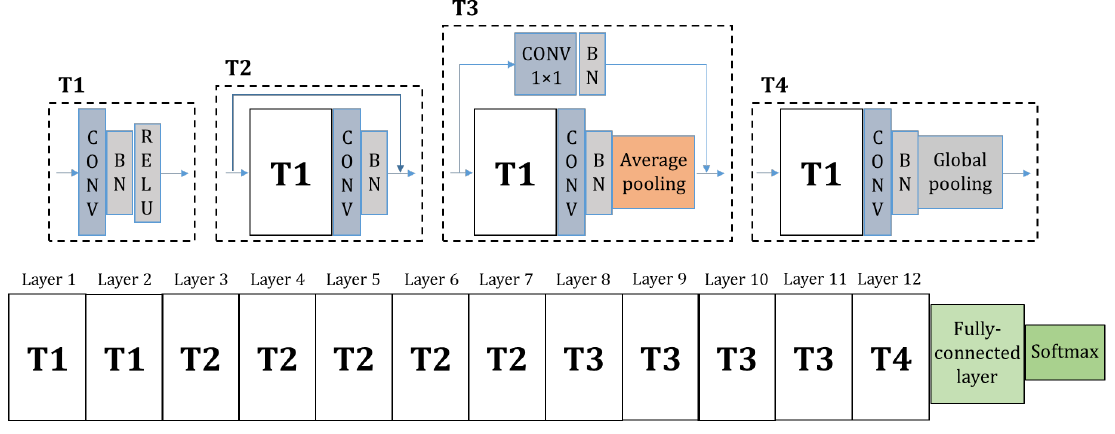
Figure 8. Structure of a deep residual network used in